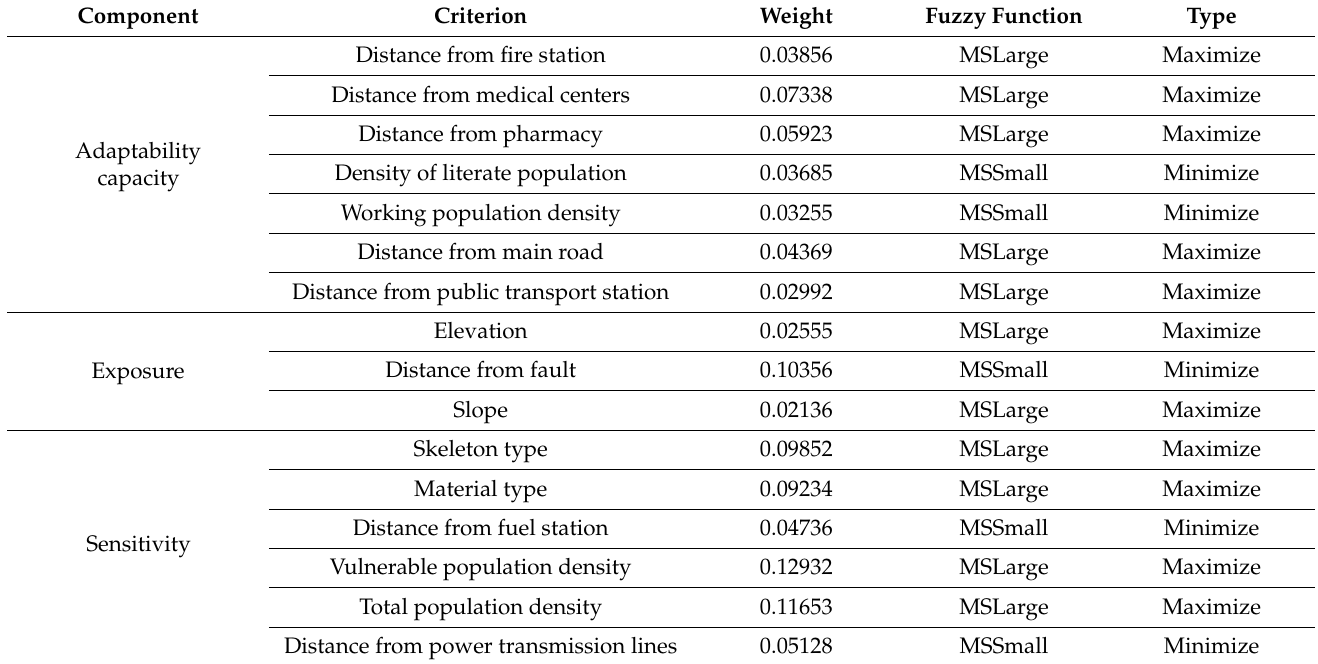
Table 3. Weight and fuzzy function for the used